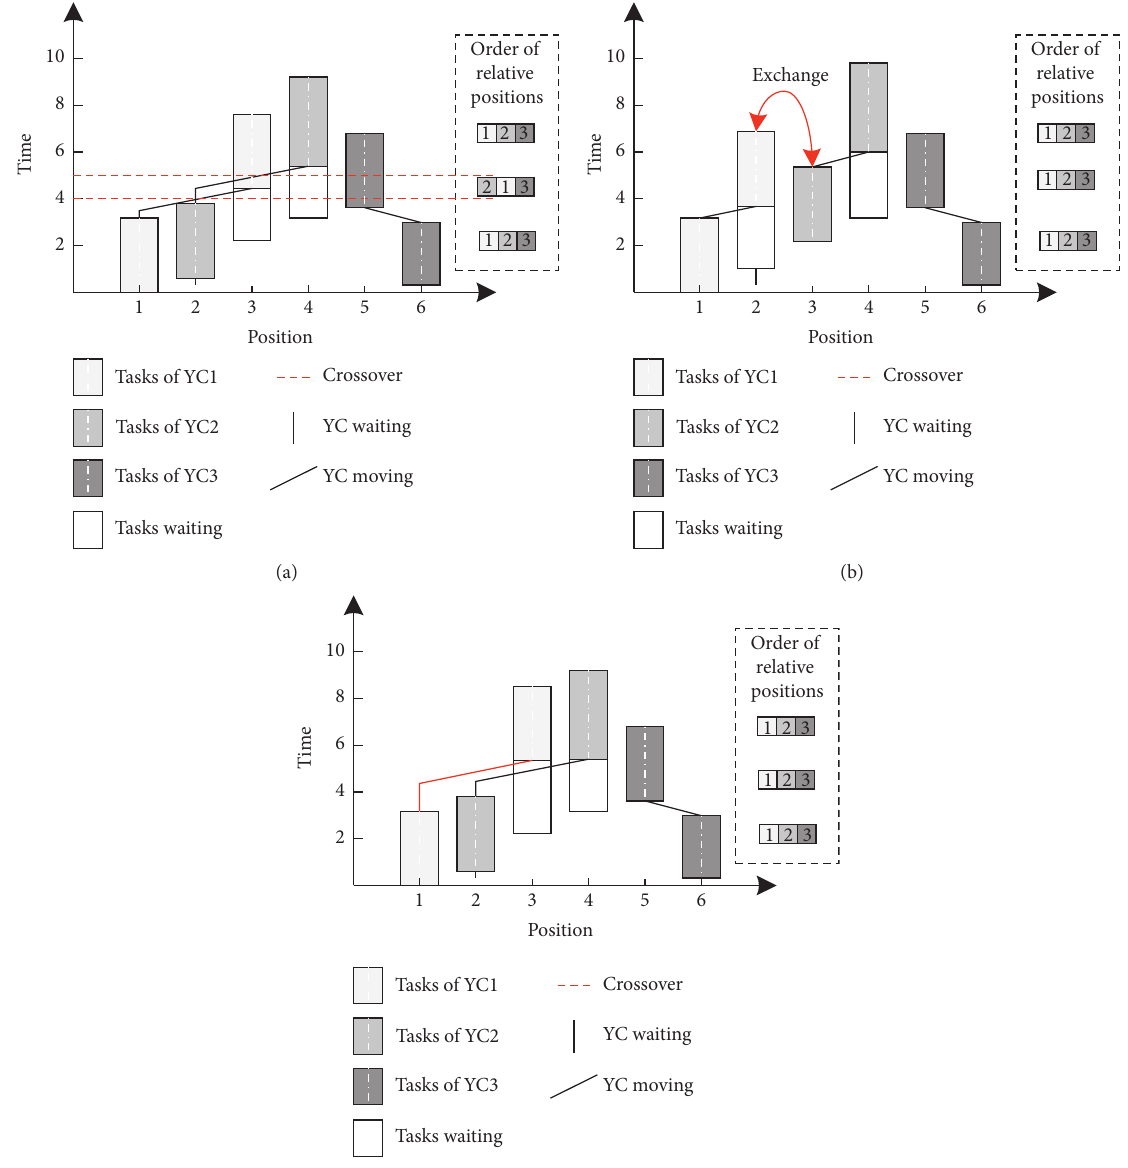
Figure 7: Repair methods of infeasible